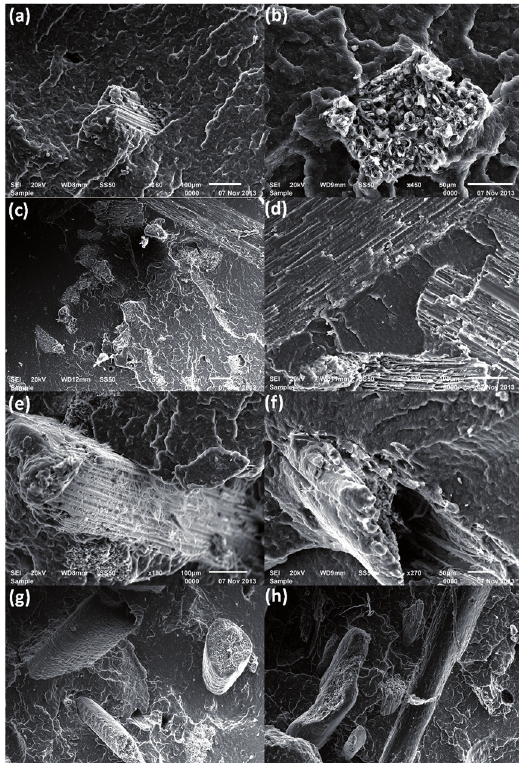
Figure 9: Micrograph of the impact-fractured samples: 80/10/10 ((a, b) - ×160, ×450), 70/10/20 ((c, d) – ×55, ×200), 60/10/30 ((e, f) – ×190, ×270), and 80/0/20 ((g, h) – ×75, ×80)